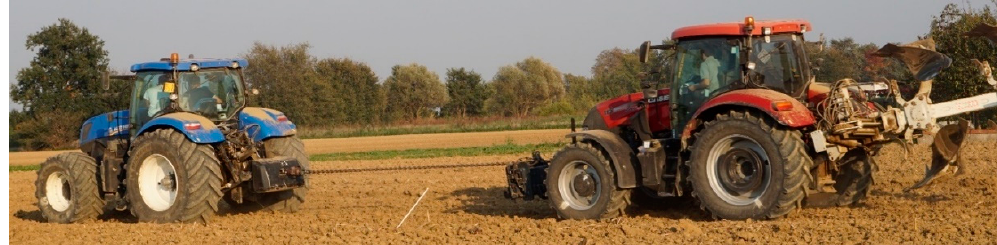
Figure 2. Drawbar test setup with the TT in the R configuration. The plough on the Case IH Maxxum 115 (LU) tractor was mounted for the sole purpose of making the LU tractor reach the weight necessary to brake the TT.